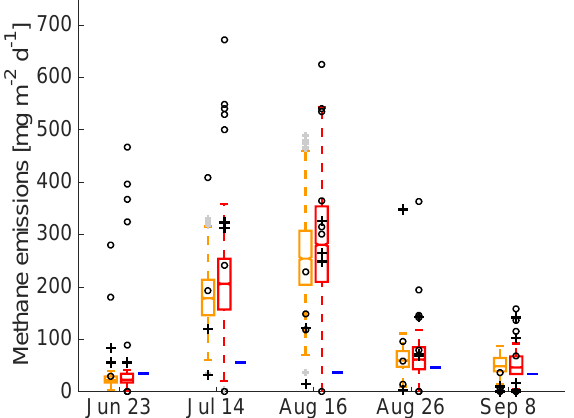
Figure 5. Box plots of simulated methane emissions in hummocks (orange boxes) m and hollows (red boxes) against measurements from the bog (black crosses) and from the rest of the peatland (black circles). Grey crosses are outliers in the simulation. The blue line represents the output of the model without representation of micro- topography. The box plot parameters regulating the length of the whiskers are the default values for covering 99 . 3% of the data if the data are normally